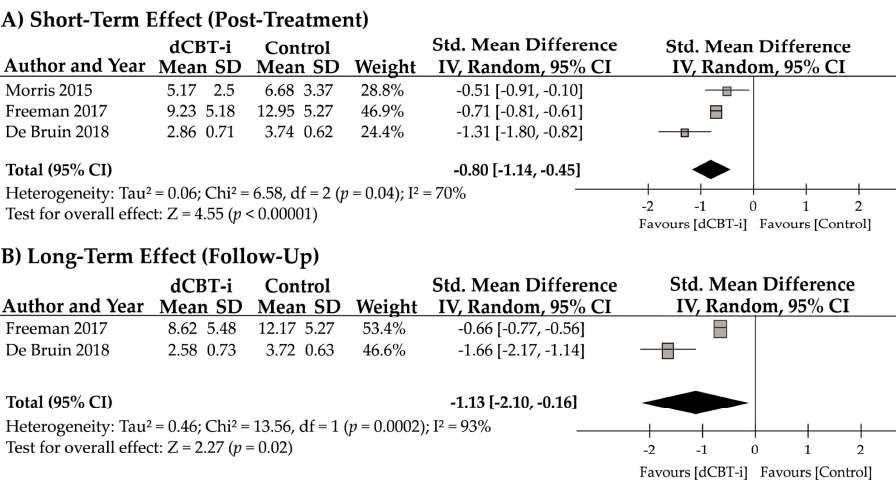
Figure 5. Sensitivity analysis of the short- and long-term effects of dCBT-i on subjective sleep quality (SQ). Subjective SQ was evaluated using the Pittsburgh Sleep Quality Index (PSQI; Morris et al., 2015 [30]), Insomnia Severity Index (ISI; Freeman et al., 2017 [43]), or Holland Sleep Disorder Questionnaire-Insomnia (HSDQi; De Bruin et al., 2018 [45]). SD, standard deviation; CI, confidence interval.